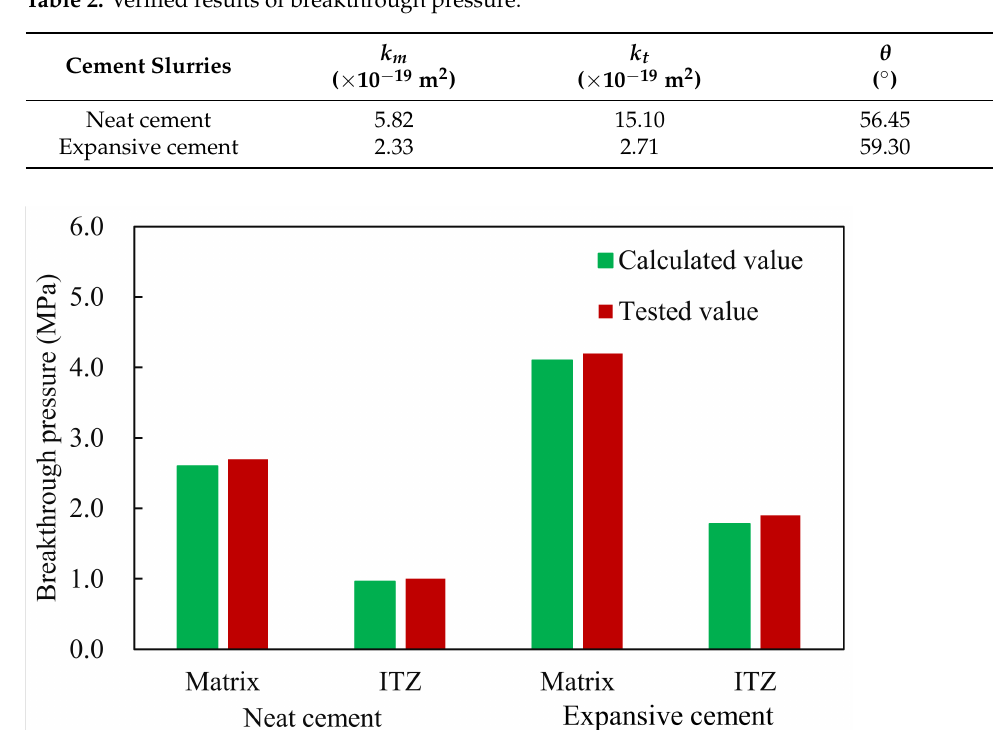
Figure 3. Experimentally verified results of breakthrough pressure of matrix and ITZ .